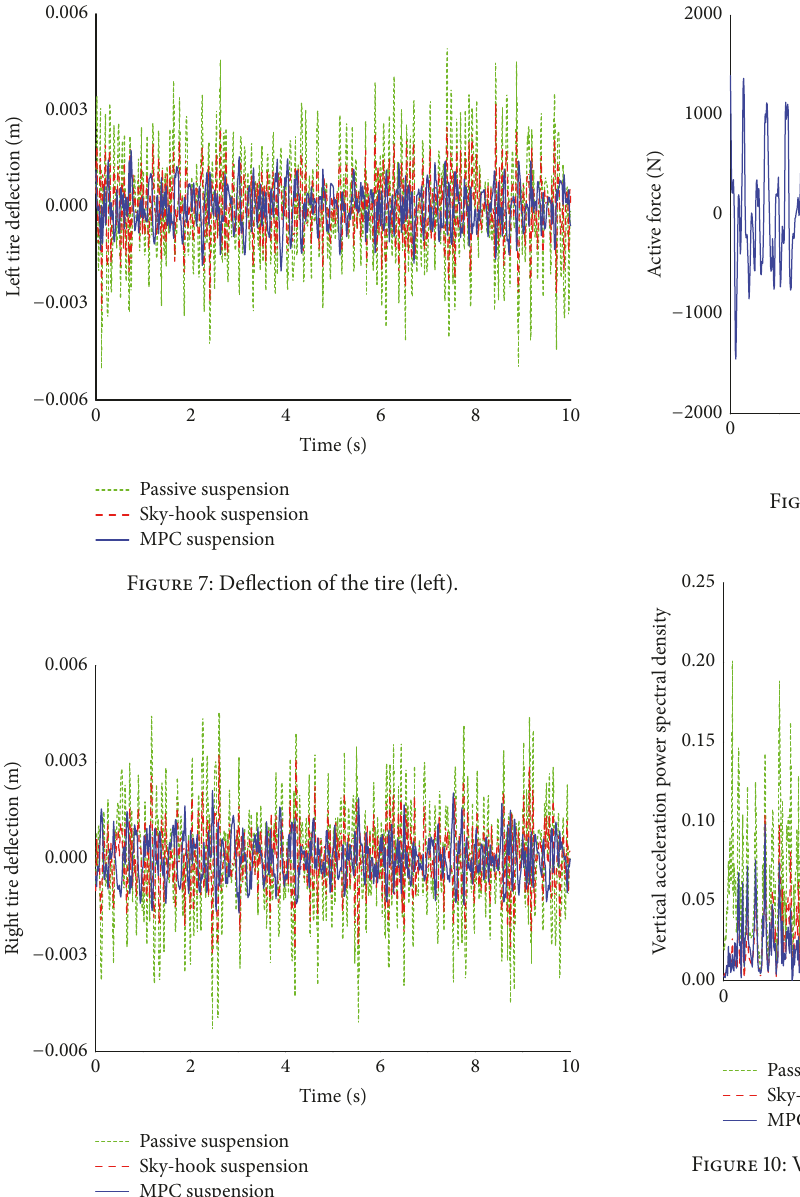
Figure 8: Deflection of the tire (right).